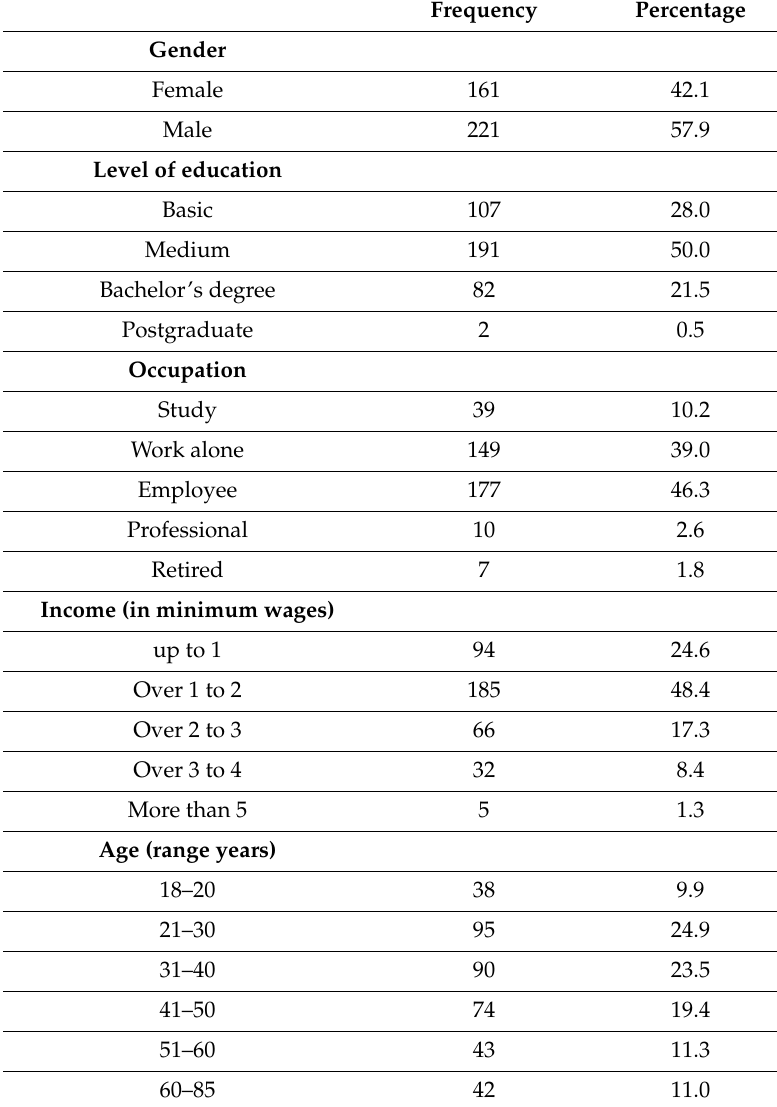
Table 7. Demographic characteristics of the